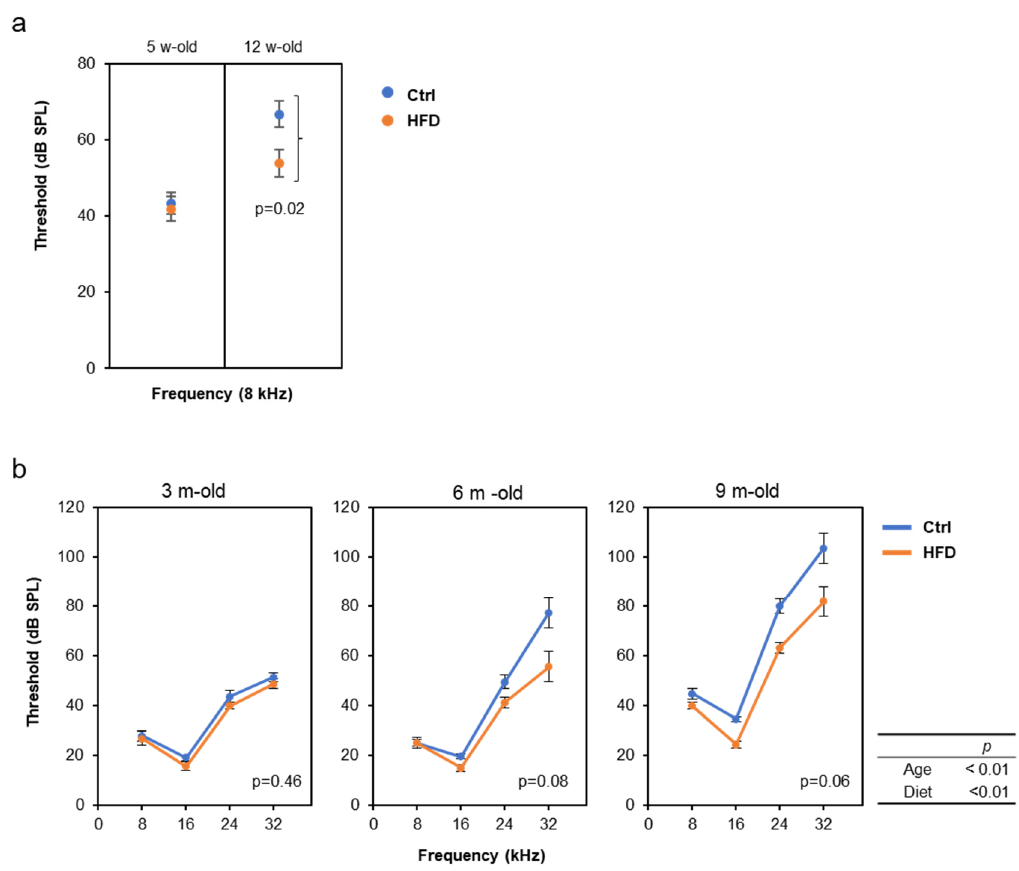
Figure 4. High-fat diet (HFD) attenuated age-related hearing loss (AHL) in DBA / 2J and C57BL / 6J mice: ABR were measured at the age of 5 and 12 w-old in male DBA / 2J mice ( a , N = 8 each) and at 3 and 9 m-old in male C57BL / 6J mice ( b , N = 8 each). Since the threshold at 12 w-old was above the measurement limit for frequencies above16 kHz, only 8 kHz results are used for DBA mice. The statistical p -values of two-way repeated measures ANOVA are shown in the right table in b, the p -values by comparing the diet condition with the t-test ( a ), or one-way repeated measures ANOVA ( b ) are shown in the figures.